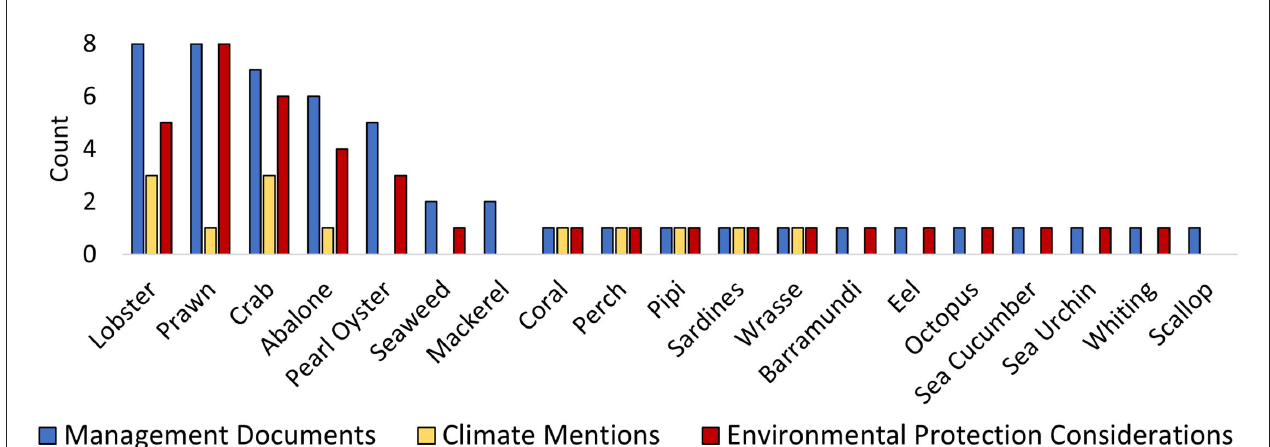
FIGURE 6 | The Number of Management Documents, Climate Mentions, and Environmental Protection Considerations for each of the 19 Single-Species Groups. Species name orders are by highest to lowest Number of Management Documents, then by highest to lowest Number of Climate Mentions, and then by highest to lowest Number of Environmental Protection